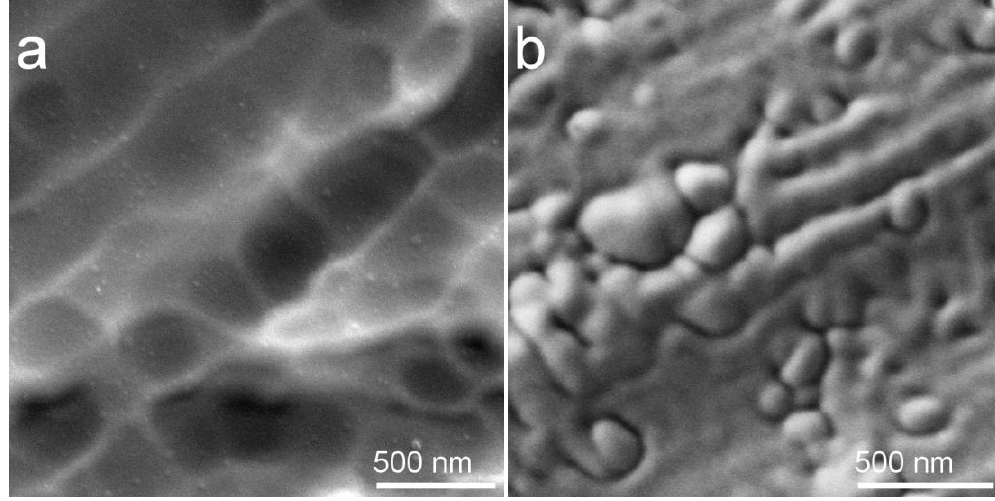
Figure 3. As-deposited Cu-HA coating on Mg0.8Ca ( a ) and on Ti substrate ( b ).